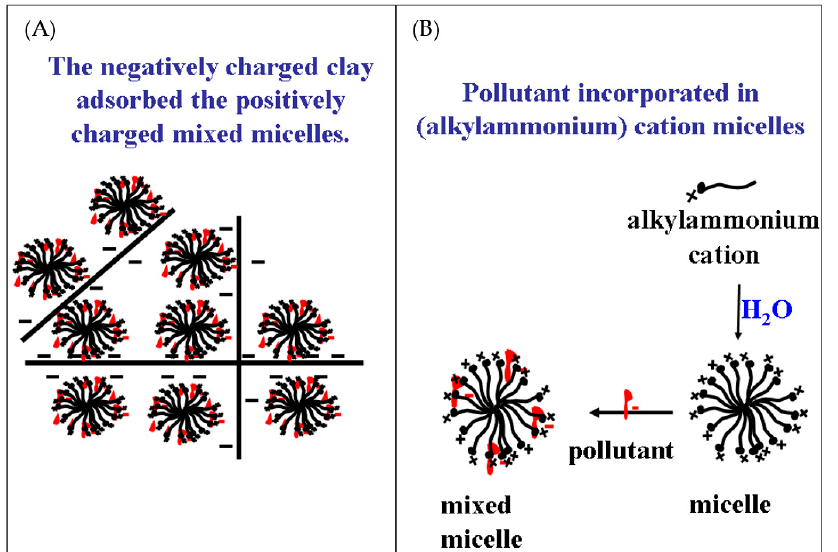
Figure 1. ( A ) The powder of the clay-mineral, such as Na-montmorillonite or a clay, such as Na- bentonite is introduced and a complex is spontaneously formed by interactions of the posi-tively charged micelles with the negatively charged clay-mineral or clay. In this scheme the mi-celle-clay complex includes the herbicide. In the absence of herbicide or pollutant molecules this Figure represents a scheme of the first stages of preparation of a micelle-clay complex. It should be noted that the sizes of micelles are in the nanometer range, whereas the lateral dimensions of the clay platelets (whose projections in the plane of the page are seen) are about 1 µ m and their width is about 1.5 nm. ( B ) The salt of an organic cation with a long alkyl chain is introduced into a vessel with water. Above a concentration denoted critical micelle concentration ( CMC ) micelles of the cation form spontaneously in sizes of a few nanometers. The red colored molecules “pollutant” are herbicide molecules in the case of a preparation of slow release formulations of